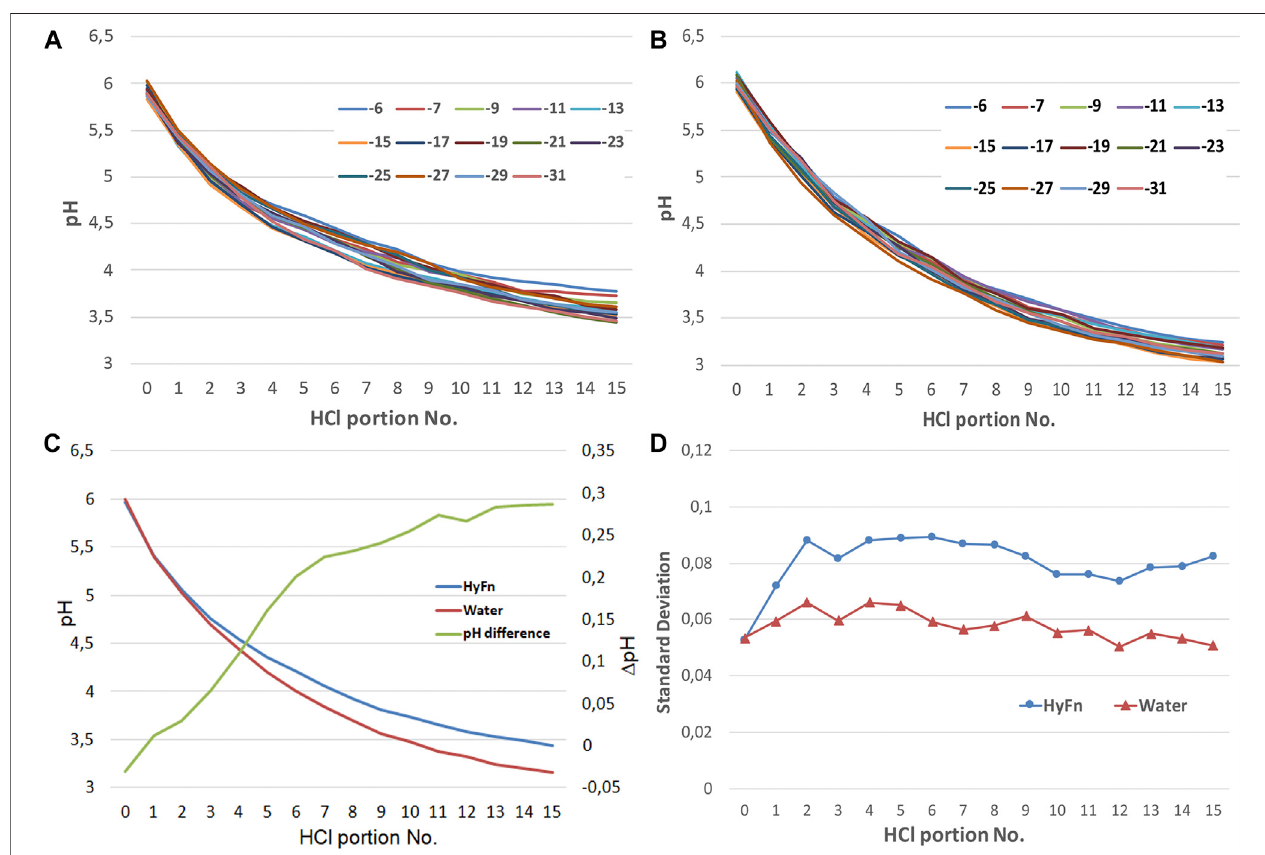
FIGURE 1 | Typical examples of titration curves of series No 1 (out of 6) dilutions of HyFn (A) and “ dilutions ” of water (B) (from 10 – 7 to 10 – 31 M) with HCl. The abscissaaxisrepresentsnumbersoftheportionsofHClinjections(10 μ Leach)addedtothetitratedsamples,theordinateisthepHvalue.Eachlineon (A,B) represents aparticular dilution ofHyFnorwaterdilutioncorrespondingtocalculatedHyFnmolarconcentrationsindicatedintheplotsaslg[HyFn] (C) Averagedtitration curvesofall HyFn dilutions (blue line) and water “ dilutions ” (red line) for all the series of experiments; green line: difference in pH values between HyFn dilutions and water “ dilutions. ” (D) Standard deviations from the mean pH values averaged over all series of experiments, varying during the titration of HyFn dilutions and water “ dilutions ” (from 10 – 7 to 10 – 31 M) with